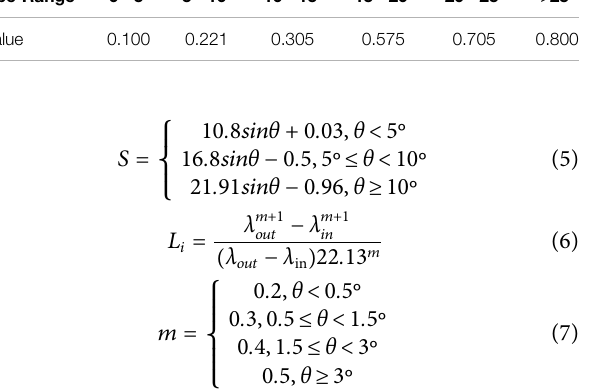
TABLE 1 | The p -value of cultivated land in different slope ranges. Slope